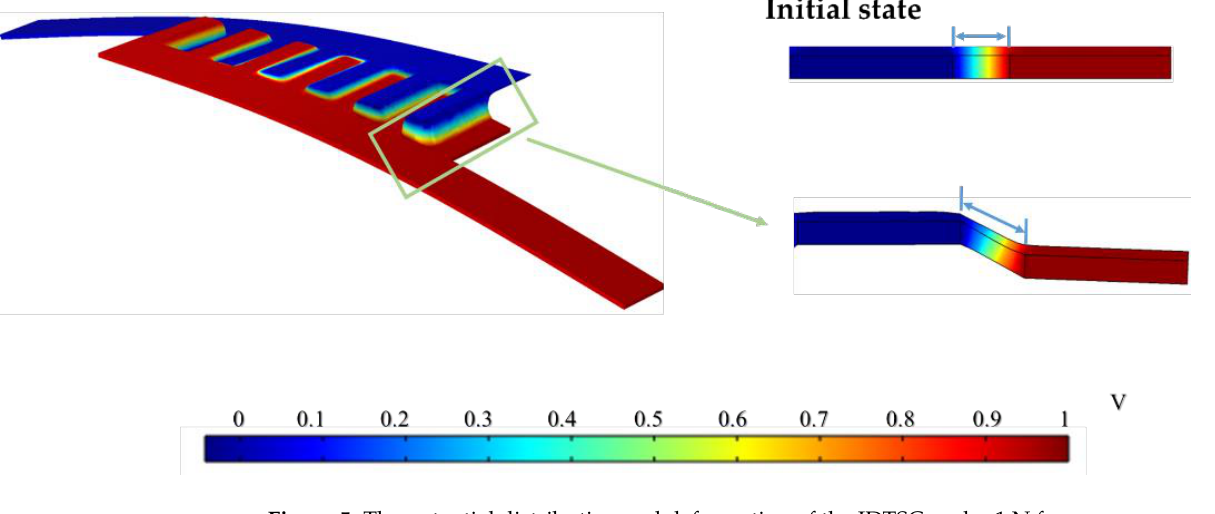
Figure 5. The potential distribution and deformation of the IDTSC under 1 N force.